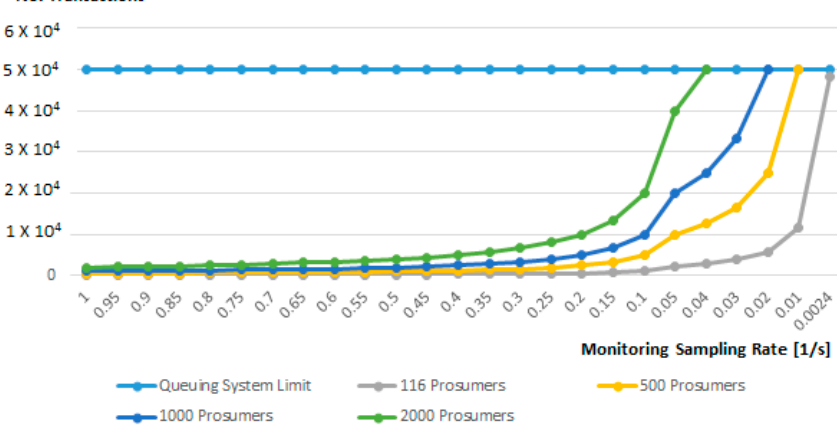
Figure 11. Off-chain monitoring sampling rate and the number of prosumers. Figure 11. O ff -chain monitoring sampling rate and the number of